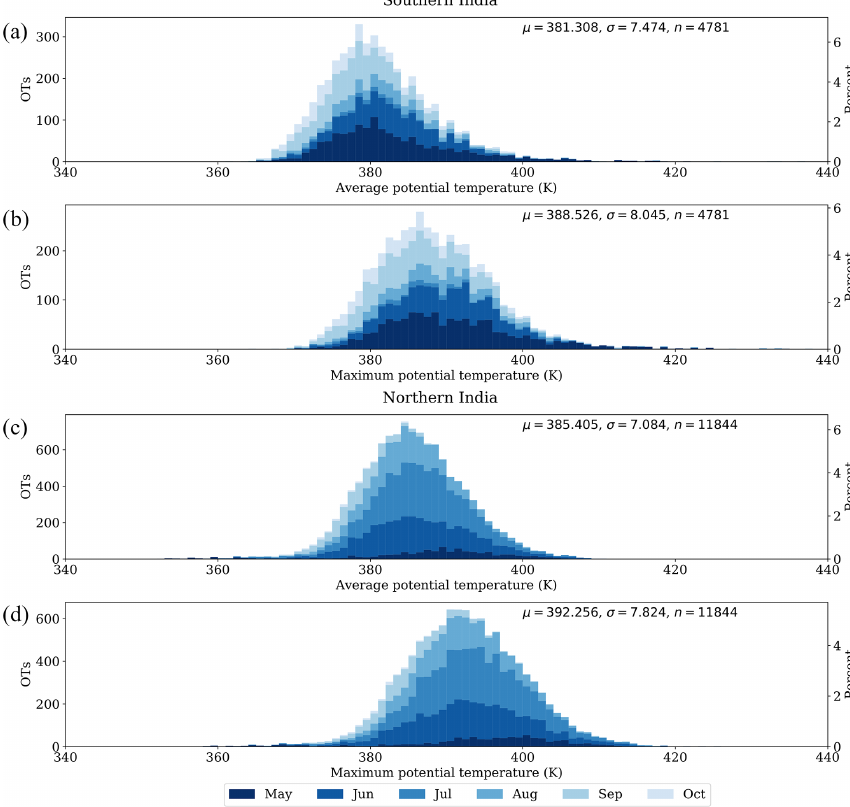
Figure 5. The potential temperature distribution of OTs within the Southern India (a, b) and Northern India (c, d) regions. Panels (a) and (b) show the distributions of the average and maximum potential temperature of OTs occurring within the Southern India region binned by 1K, respectively. Panels (c) and (d) show the distributions of the average and maximum potential temperature of OTs occurring within the Northern India region binned by 1K, respectively. Within each bin, color indicates the fractional contribution of each month, as in Fig. 4. The mean, standard deviation, and number of OTs for each distribution are indicated in the upper-right